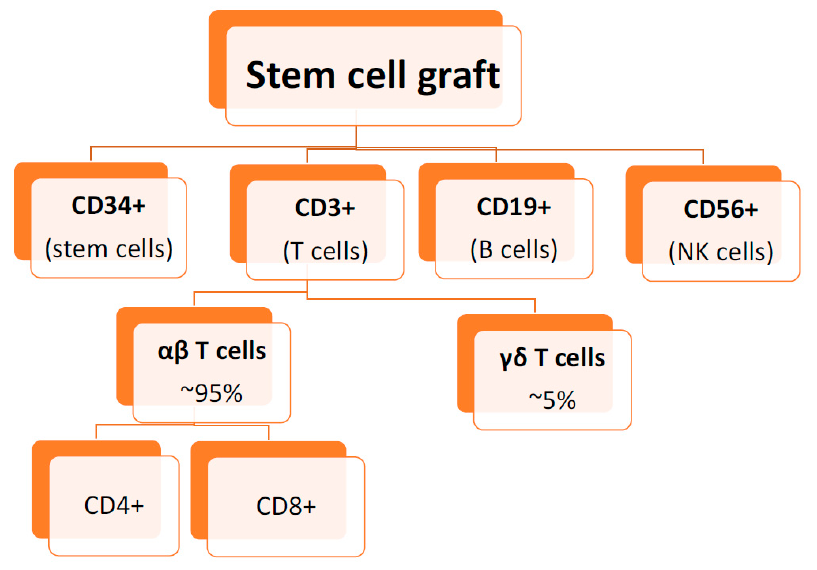
Figure 2. Key Component of the stem cell graft.